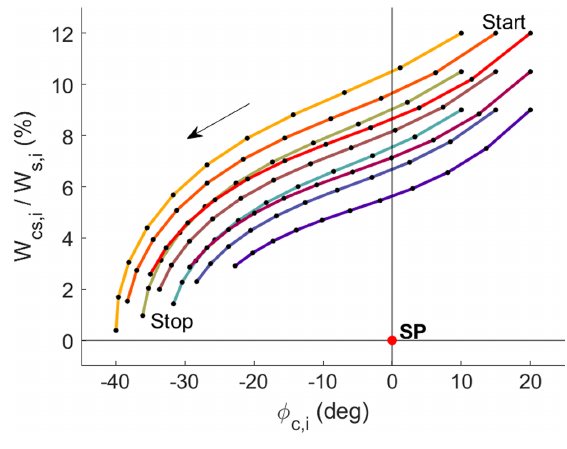
FIG. 6. Optional center particles ’ paths around the synchronous particle for a ten-gap KONUS section. The ordinate shows the relative energy deviation against the SP with its energy increasing in each gap. Dots mark